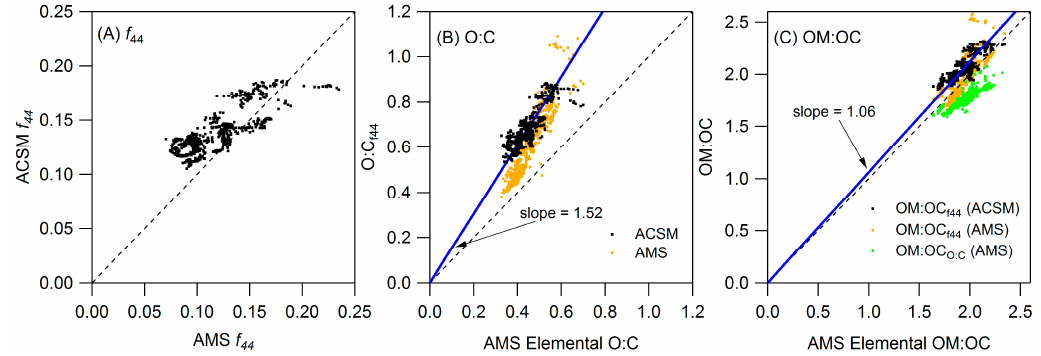
Figure A2. Comparison of ( A ) f 44 ; ( B ) O:C and ( C ) OM:OC between the HR-ToF-AMS and ACSM.